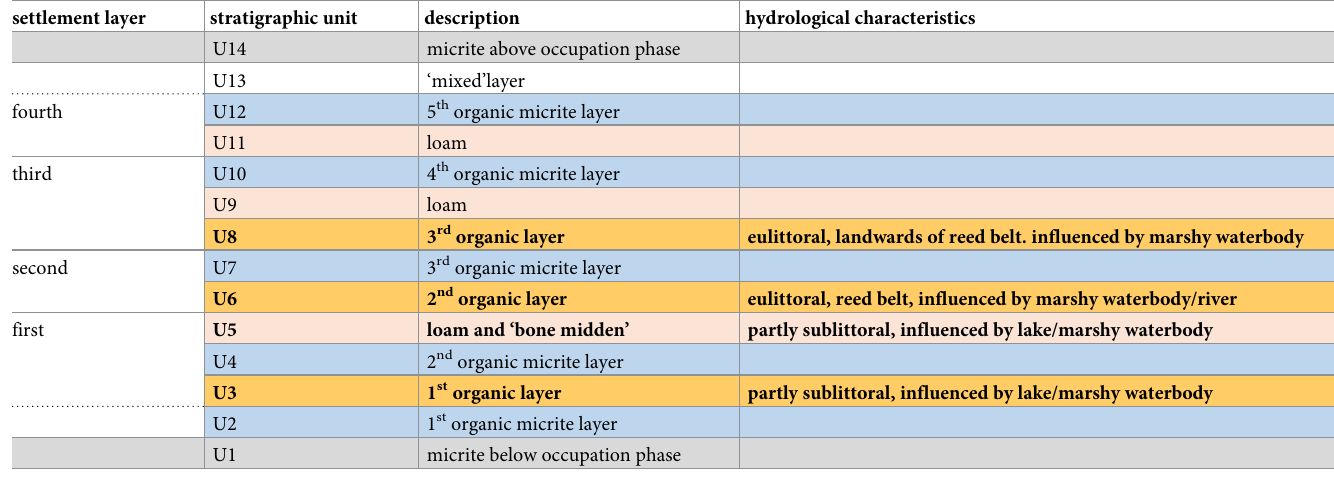
Table 1. Listing of the phase of occupation, settlement layers, stratigraphic units and sediment types of the site of Zug-Riedmatt. Specific stratigraphical units that are the focus of this article are marked in bold. Sediment types: orange = organic, blue = organic micrite, grey = micrite, pink = loam, white = mixed. settlement layer stratigraphic